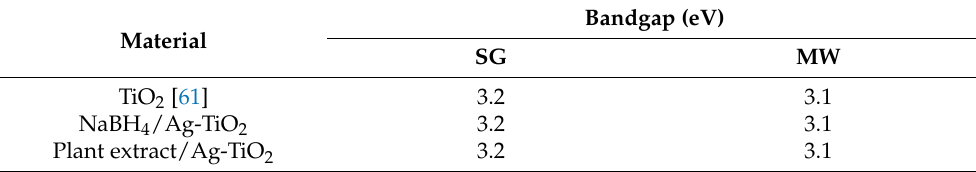
Table 4. Ag-TiO 2 bandgap values.